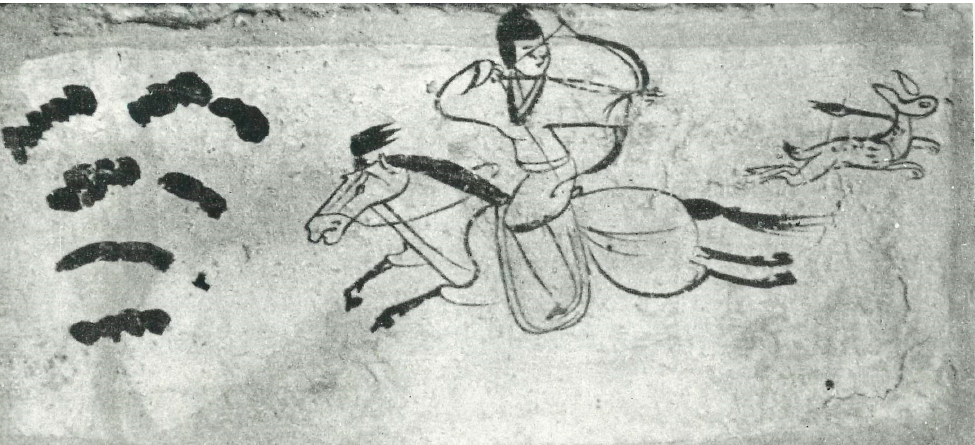
Figure 9. Female hunter on horseback, north wall of front chamber, Xincheng M5, painting on brick, Wei-Jin period (220–317). (Gansusheng Bowuguan et al. 1985, pl. 79.1). ©Wenwu Press. This figure published with permission of Wenwu Press and cannot be used or copied without their